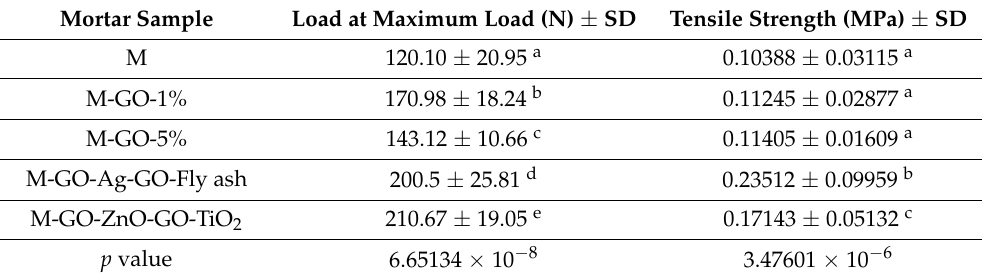
Table 5. Adhesive strength of the mortars (following the Tukey test: groups of specimens marked with the same letter show no statistically significant differences between them; the groups marked with different letters show statistically significant differences between them). Mortar